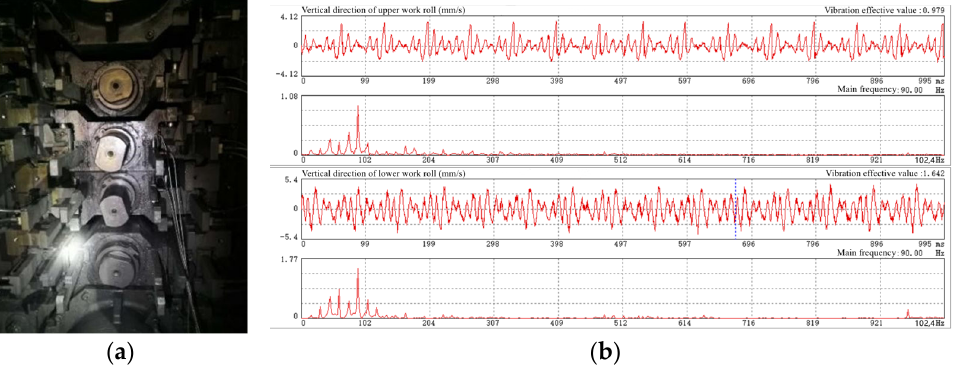
Figure 1. On − site vibration test diagram of upper and lower work rolls of cold rolling mill: ( a ) testing diagram in the factory; ( b ) spectrum diagram of upper and lower work roll test.